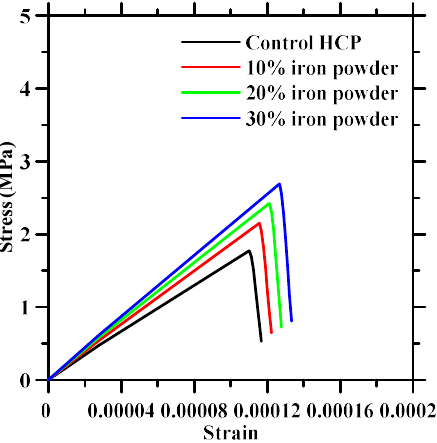
Figure 6. Simulated tensile constitutive response of pastes with varying iron powder dosage in HCP.